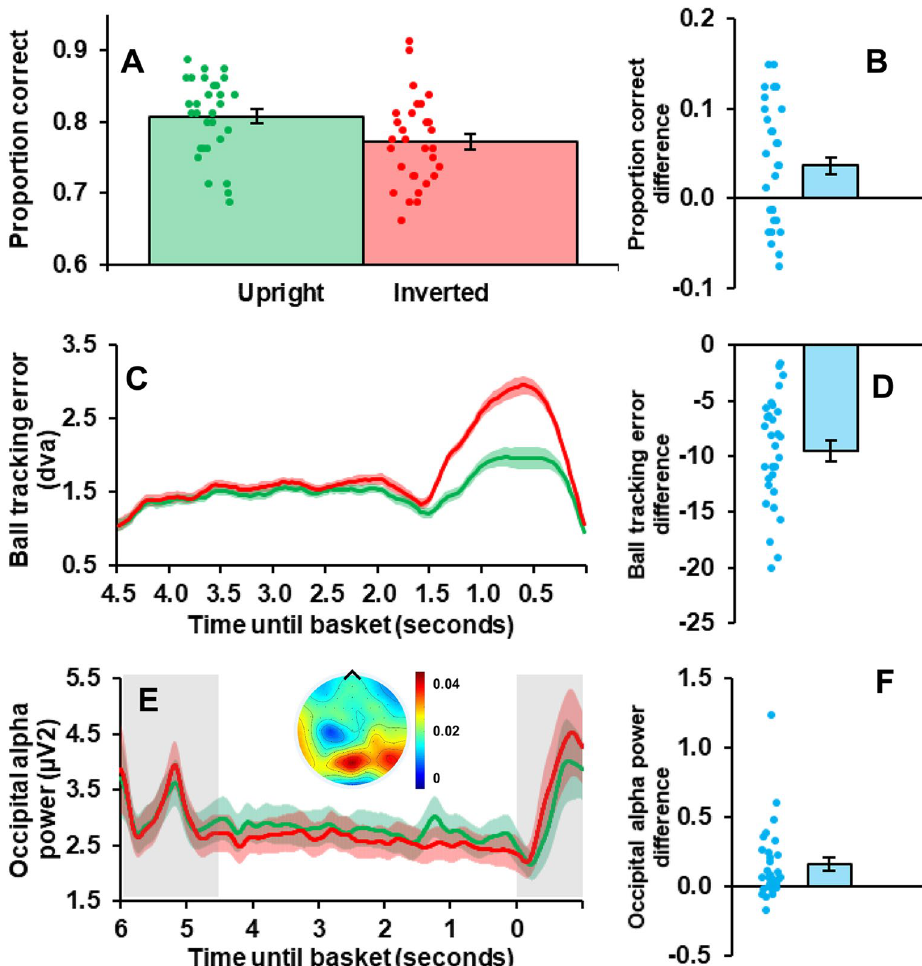
Figure 2. ( A ) Mean proportion correct scores for upright (green) and inverted (red) trials. Coloured dots depict individual participants. Error bars depict ± 1 SE across participants. ( B ) Proportion correct difference scores, taken as upright minus inverted (figure details same as ( A ). ( C ) Mean error (dva), between individual fixation positions and actual ball locations, as a function of time from video onset (seconds) for upright (green) and inverted (red) videos. Shaded regions depict SE across participants. ( D ) Ball tracking error difference scores, taken as upright minus inverted (using the full sample period; figure details same as A ). ( E ) Time–frequency data showing mean occipital alpha power (µV 2 ), as a function of time from shot outcome (0 s) for upright (green) and inverted (red) videos. Coloured shaded regions depict ± 1 SEM across participants. Depicted data include 1.5 secs pre-video onset and 1 s post-video offset (shaded grey regions). Pre-video onset, the ball localising circle was displayed over a static image (the first video frame). Post-video offset the screen was blank and the response screen was displayed. Topographic map depicts conditional difference (upright—inverted) in alpha-band (8–12 Hz) activity for full sample duration. Created using the FieldTrip toolbox for Matlab. F) Occipital alpha power difference scores, taken as upright minus inverted (using the full sample period; details as per Fig. 2A). All graphs created using Microsoft